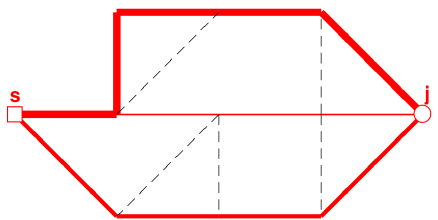
Figure 9. First, second and third shortest paths from s to j (sorted from thinnest to thickest solid lines, respectively).